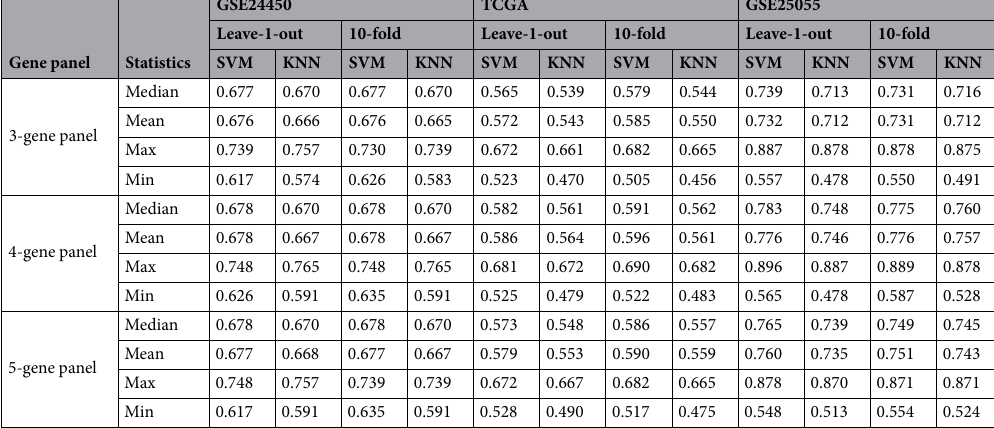
Table 1. Cross-validations of the four pivotal diagnostic genes in differentiating breast cancer subtypes. Leave- 1-out and 10-fold represent two types of cross-validations used for performance assessment. ‘SVM’ and ‘KNN’